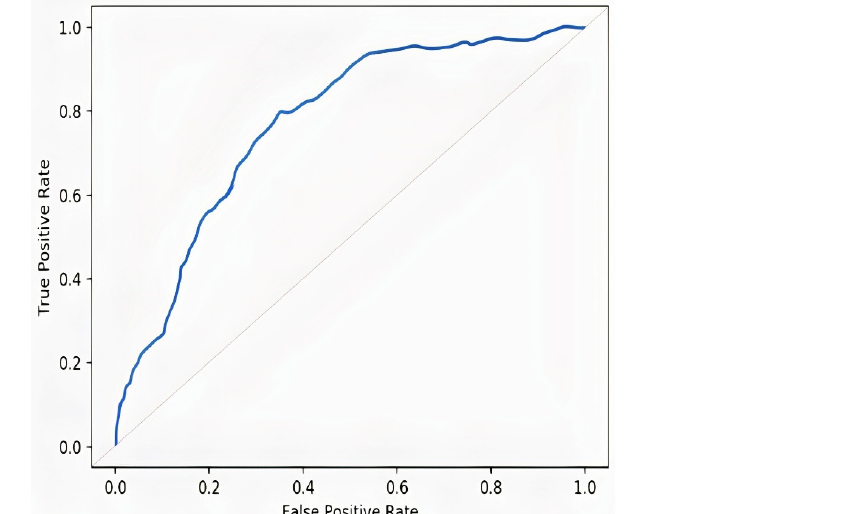
Figure 13. ROC curve of valence label.